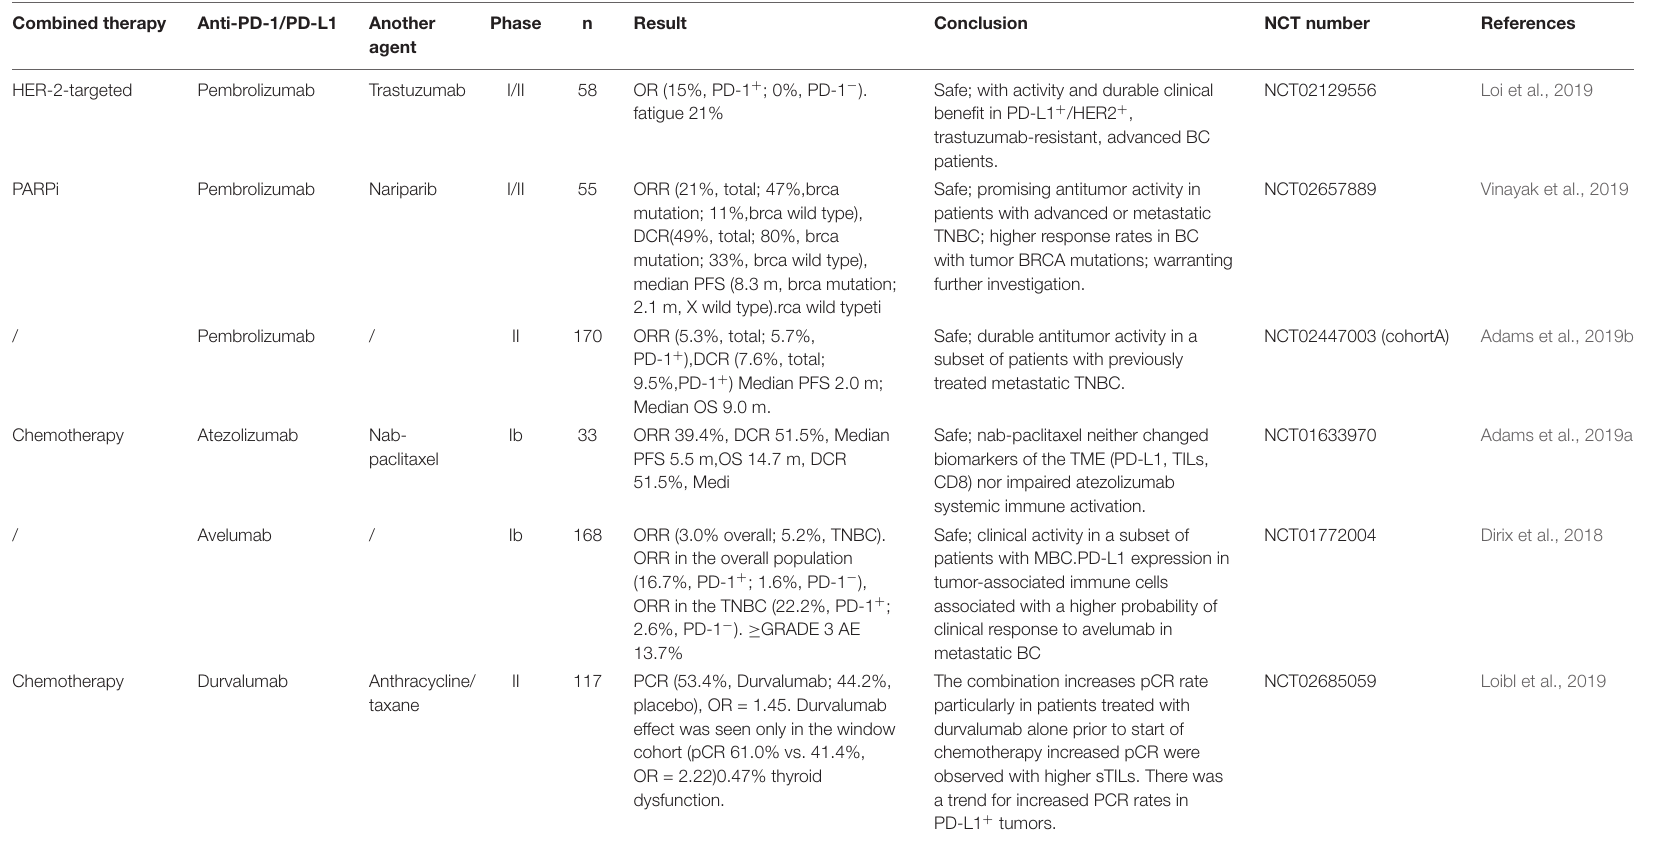
BC, breast cancer; TNBC, triple negative breast cancer; RT, radiotherapy; PD-1, programmed death protein 1; PD-L1, programmed death-ligand 1; n, numbers; HER-2, human epidermal growth factor receptor-2; PARPi, poly ADP-ribose polymerase inhibitor; ICB, immune checkpoint blockade; OR, overall response; ORR, objective response rate; DCR, disease control rate; PFS, progression-free survival; AE, adverse event; OS, overall survival; TME, tumor microenvironment; TILs, tumor infiltration